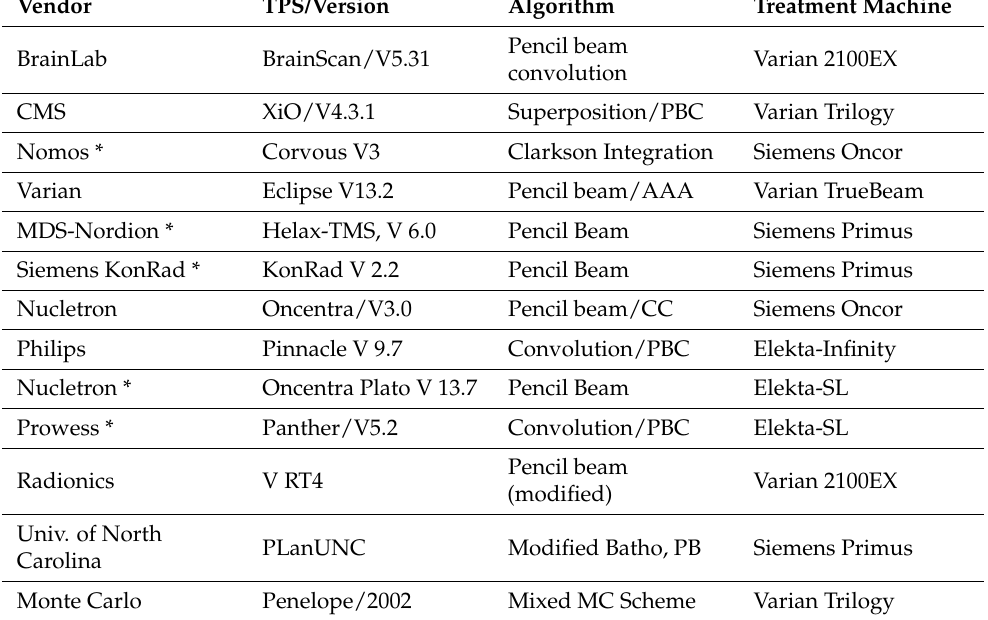
Table 2. Details of the vendor, treatment-planning system, algorithm, and inhomogeneity correction algorithms for each treatment-planning